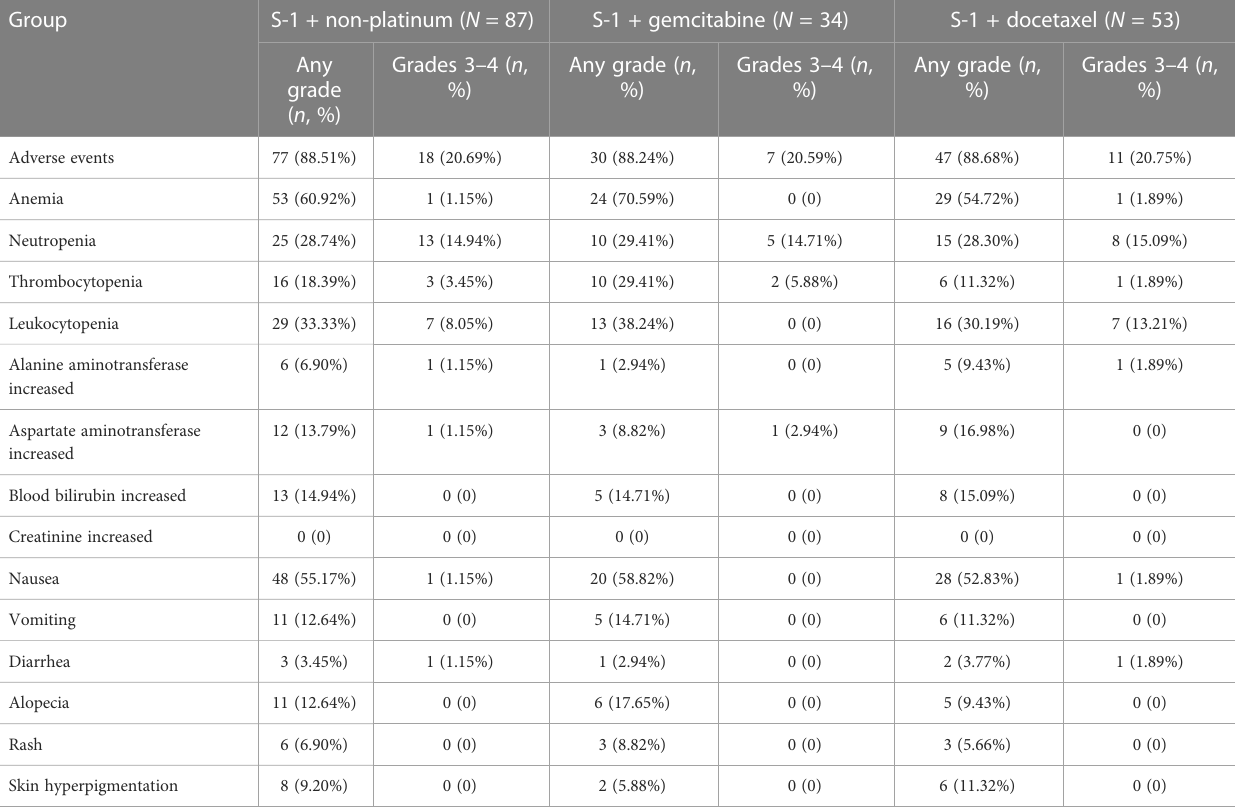
TABLE 6 Adverse events of S-1-based doublet